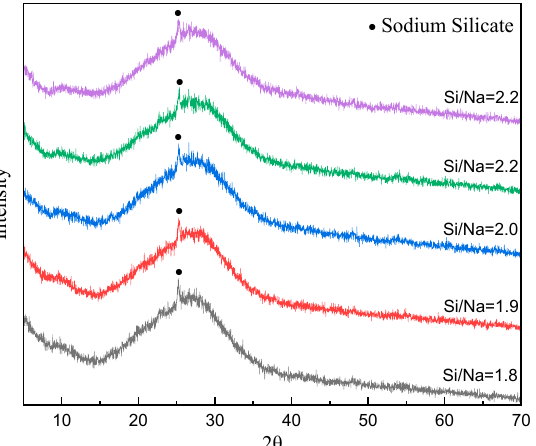
Figure 12. The XRD diagram of specimens with different Al/Na ratios (Si/Na = 2.0; age = 28 days).